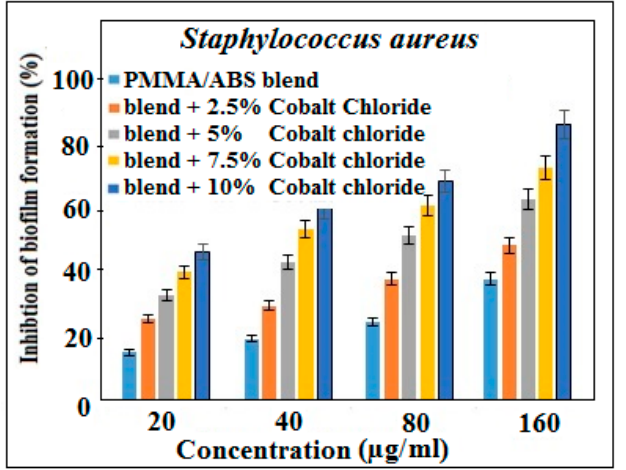
Figure 4. Biofilm inhibition activity of PMMA/ABS and PMMA/ABS/different concentrations of CoCl 2 in DMSO, p < 0.05 vs. control.